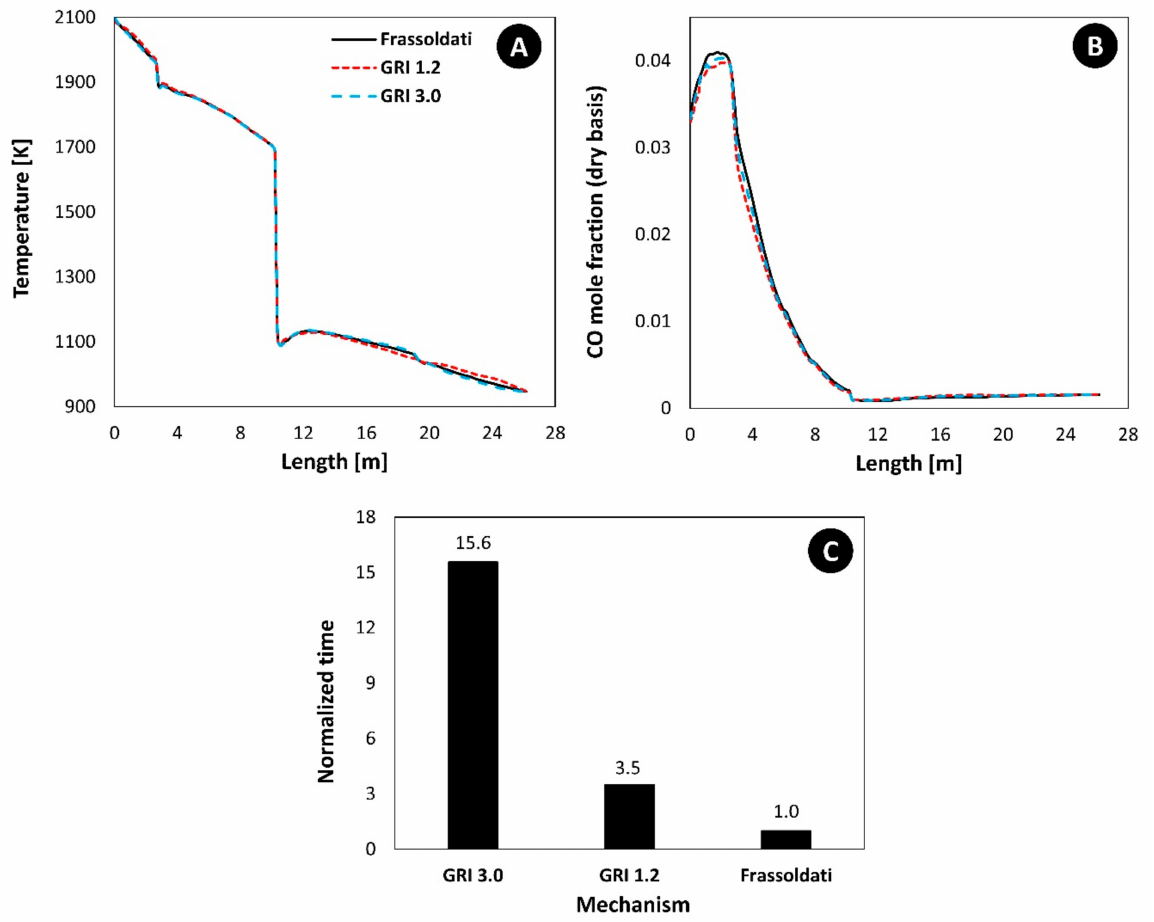
Figure 10. Predicted off-gas temperature ( A ), CO model fraction ( B ), and normalized simulation time ( C ) for different detailed